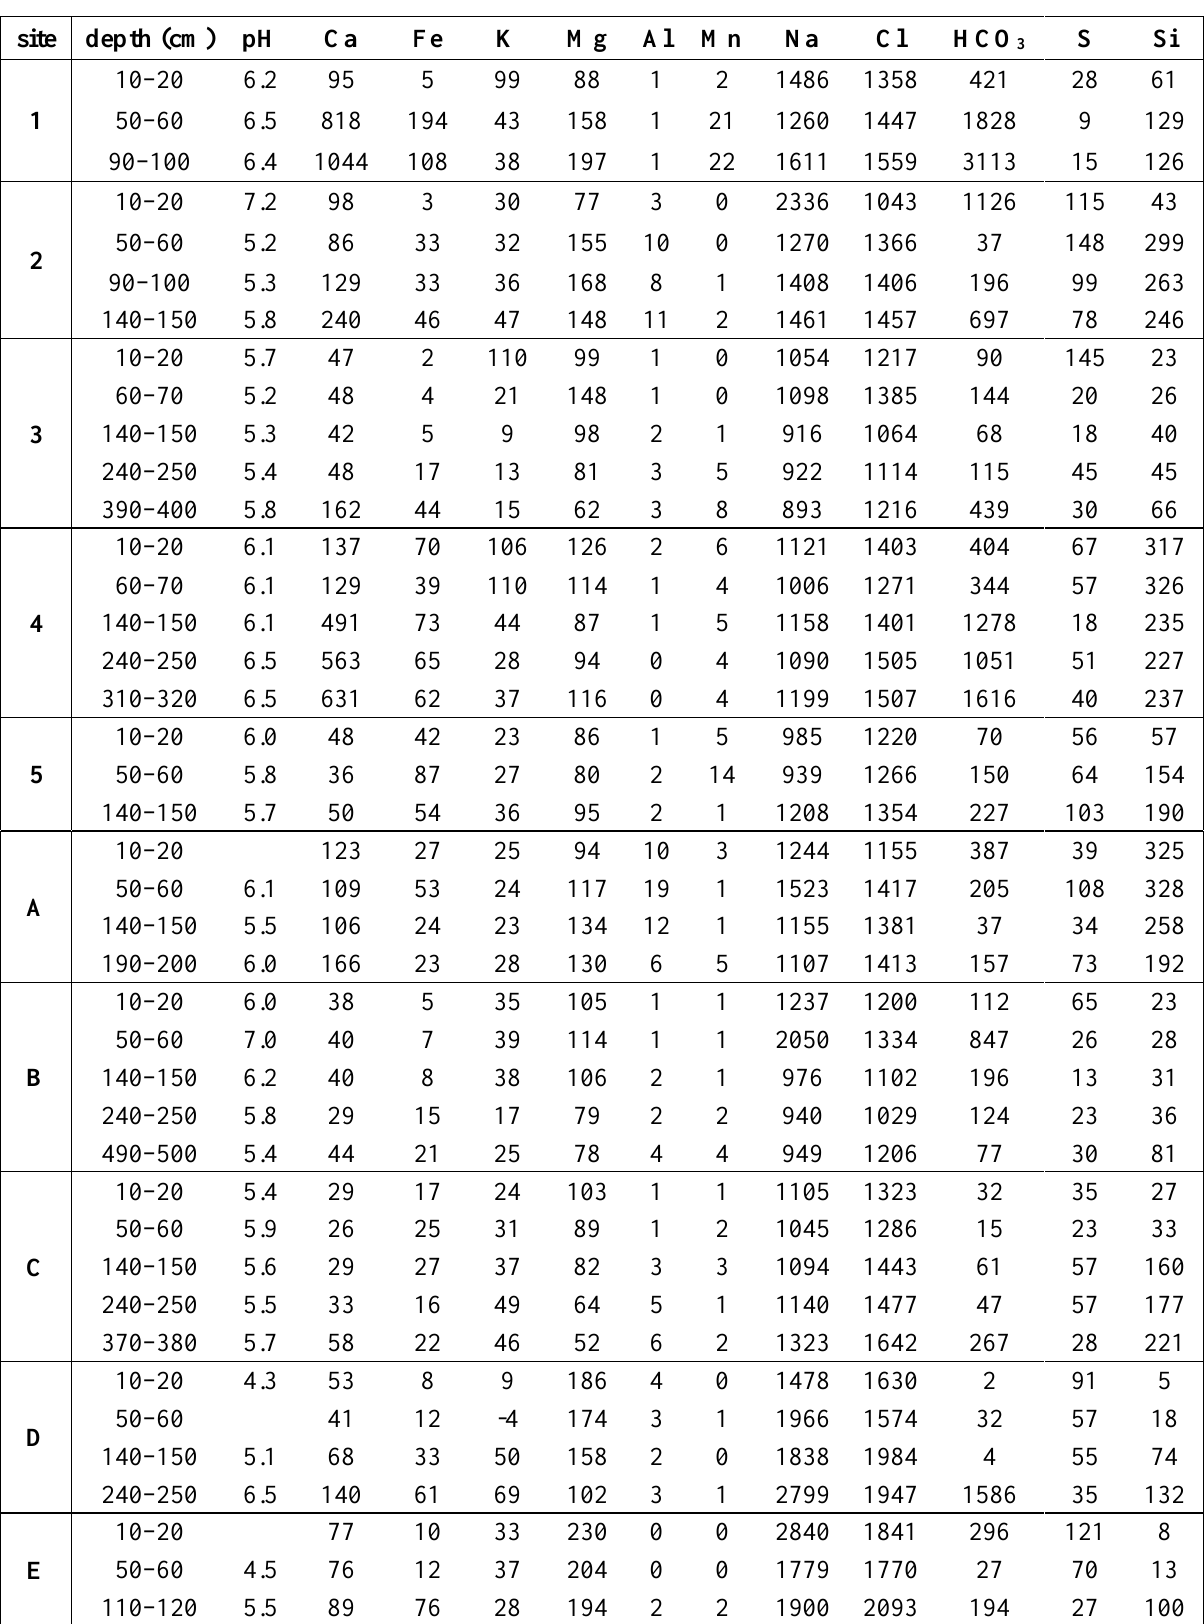
Table A2. Pore-water composition of the sampling stations at different depths in µmol L -1 (June 2014). site depth